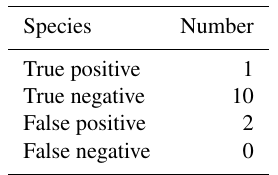
Table 2. Outcomes of patients receiving antibiotics at the time of